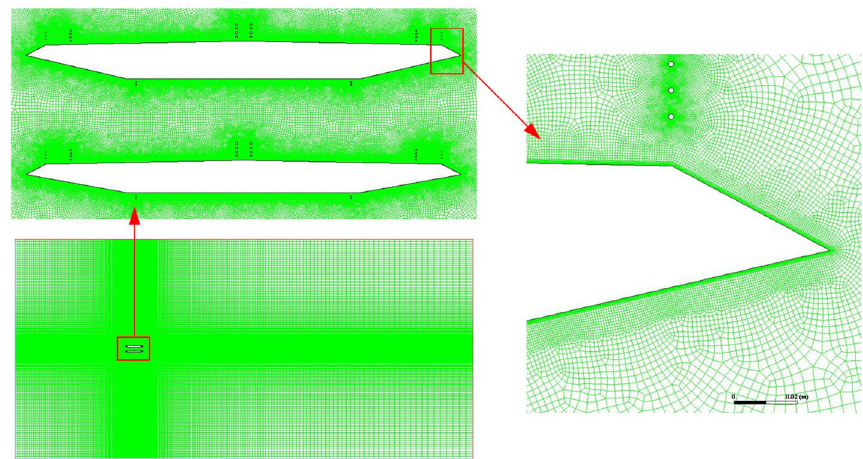
Fig. 3 Local computational mesh employed in numerical simulations